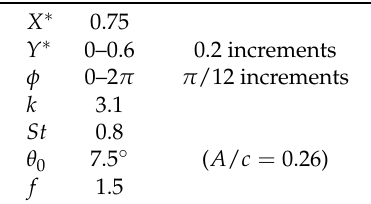
Table 1. Experimental parameters and input variables used in the present